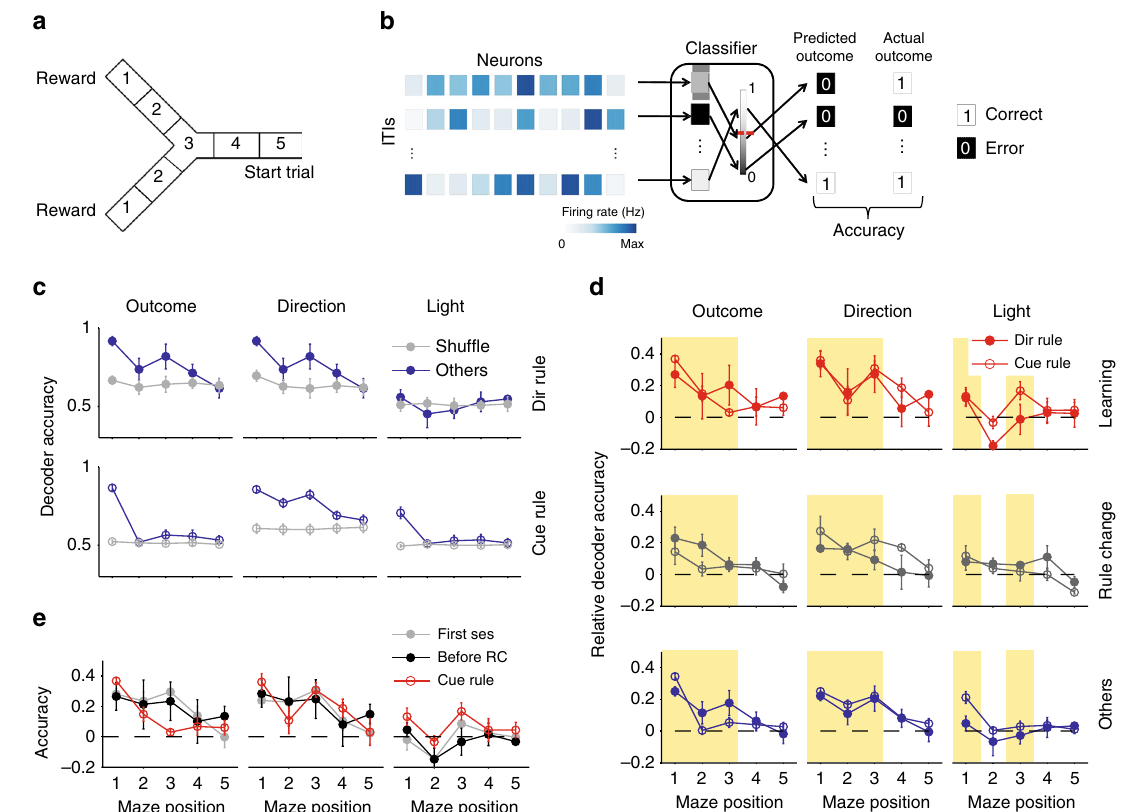
Fig. 5 Position-dependent encoding of recent task-relevant information. a Division of the maze into fi ve positions. Position 1 is the goal arm end. Position 3 is the choice point during the trial. b Schematic of decoding task events. For each inter-trial interval, and for each position in the maze, the population ’ s fi ring rate vector is input to a linear decoder. The decoder is trained to classify the population vector with one of two possible labels (here, error or correct prior outcomes), given a threshold (red dashed line) on the decoder ’ s output. The decoder ’ s accuracy is the proportion of correctly predicted labels on held-out data. c Example decoder accuracy as a function of maze position for the “ other ” sessions. We plot absolute decoder performance for each of the three classi fi ed features (prior outcome, prior direction choice, and prior light positions), separated by the rule type (direction or light-cue rules). Each data point is the mean ± SEM accuracy over sessions. Chance performance is plotted in grey, de fi ned separately for each session and rule type (Methods). All panels here plot results for a logistic regression decoder; other decoders are plotted in the Supplementary Fig. 9. d Relative decoder accuracy over all session types and rule types. Each data point is the mean ± SEM decoder accuracy in excess of chance (0; dashed line) over the indicated session type (learning, rule-change, other). Highlighted groups of positions indicate consistent departures from chance performance in at least one session type. We replot these results grouped by rule-type in Supplementary Fig. 8. e Decoding of task features at the start of learning. We plot the decoding accuracy over the fi rst session of each animal (grey), over all sessions before the fi rst rule change (black), and over the fi rst light-cue session for each animal